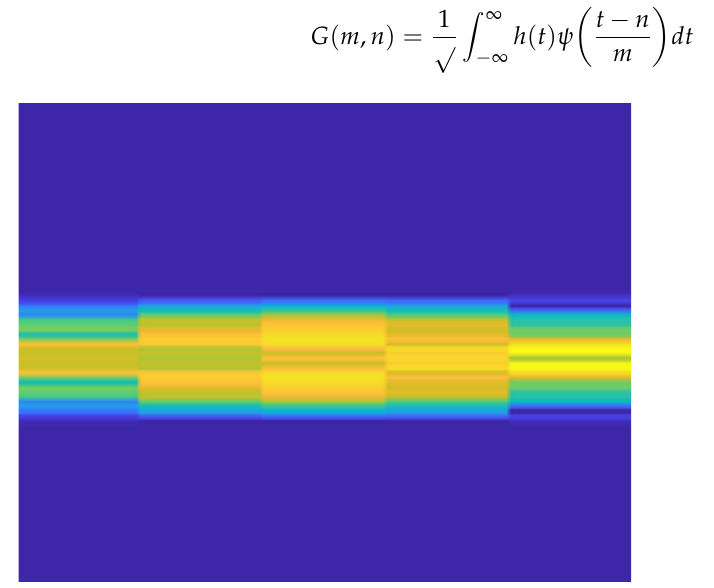
Figure 6. Time – frequency representation by